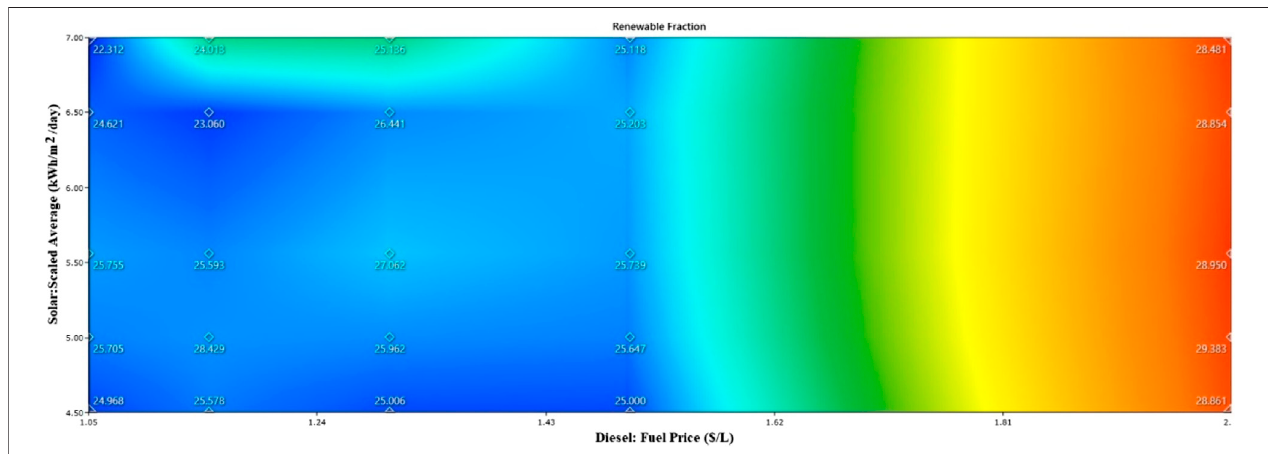
FIGURE 18 | Sensitivity analysis: diesel fuel price vs. solar radiation. Surface plot: renewable fraction; superimposed: % of excess electrical power.